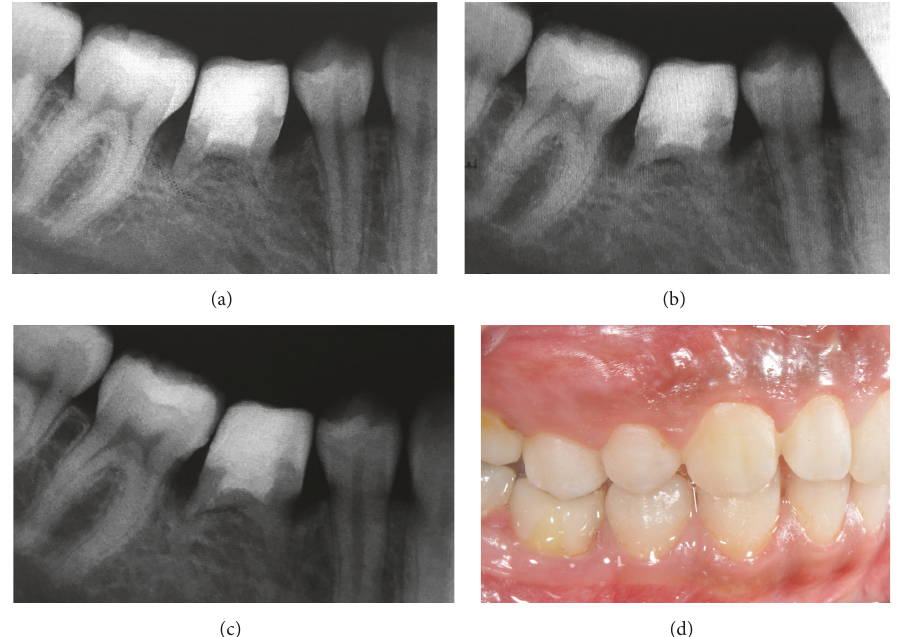
Figure 4: Follow-up views: (a) 1-year follow-up radiograph; (b) 2-year follow-up radiograph; (c) 3-year follow-up radiograph; (d) 3-year follow-up intraoral